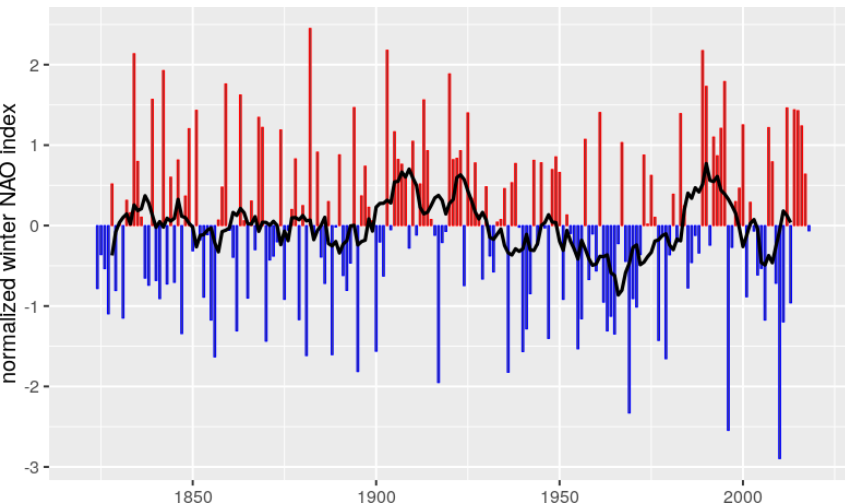
Figure 5. Normalized winter (December through March – DJFM) mean NAO index during 1821/1822–2018/2019. Red – positive; blue – negative; black – 10-year running mean. The normalisation is the (data mean (data))/standard deviation (data). Data source: https://crudata. uea.ac.uk/cru/data/nao/nao.dat (last access: 17 February 2022).